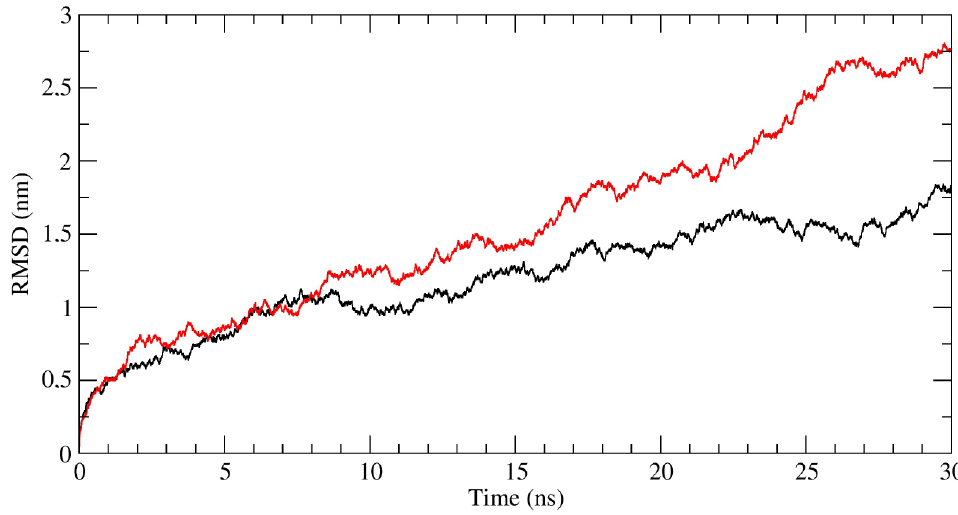
Figure 8. Time-dependent RMSD calculated for the WT (black line) and ∆ K1/K10 (red line) dimers.